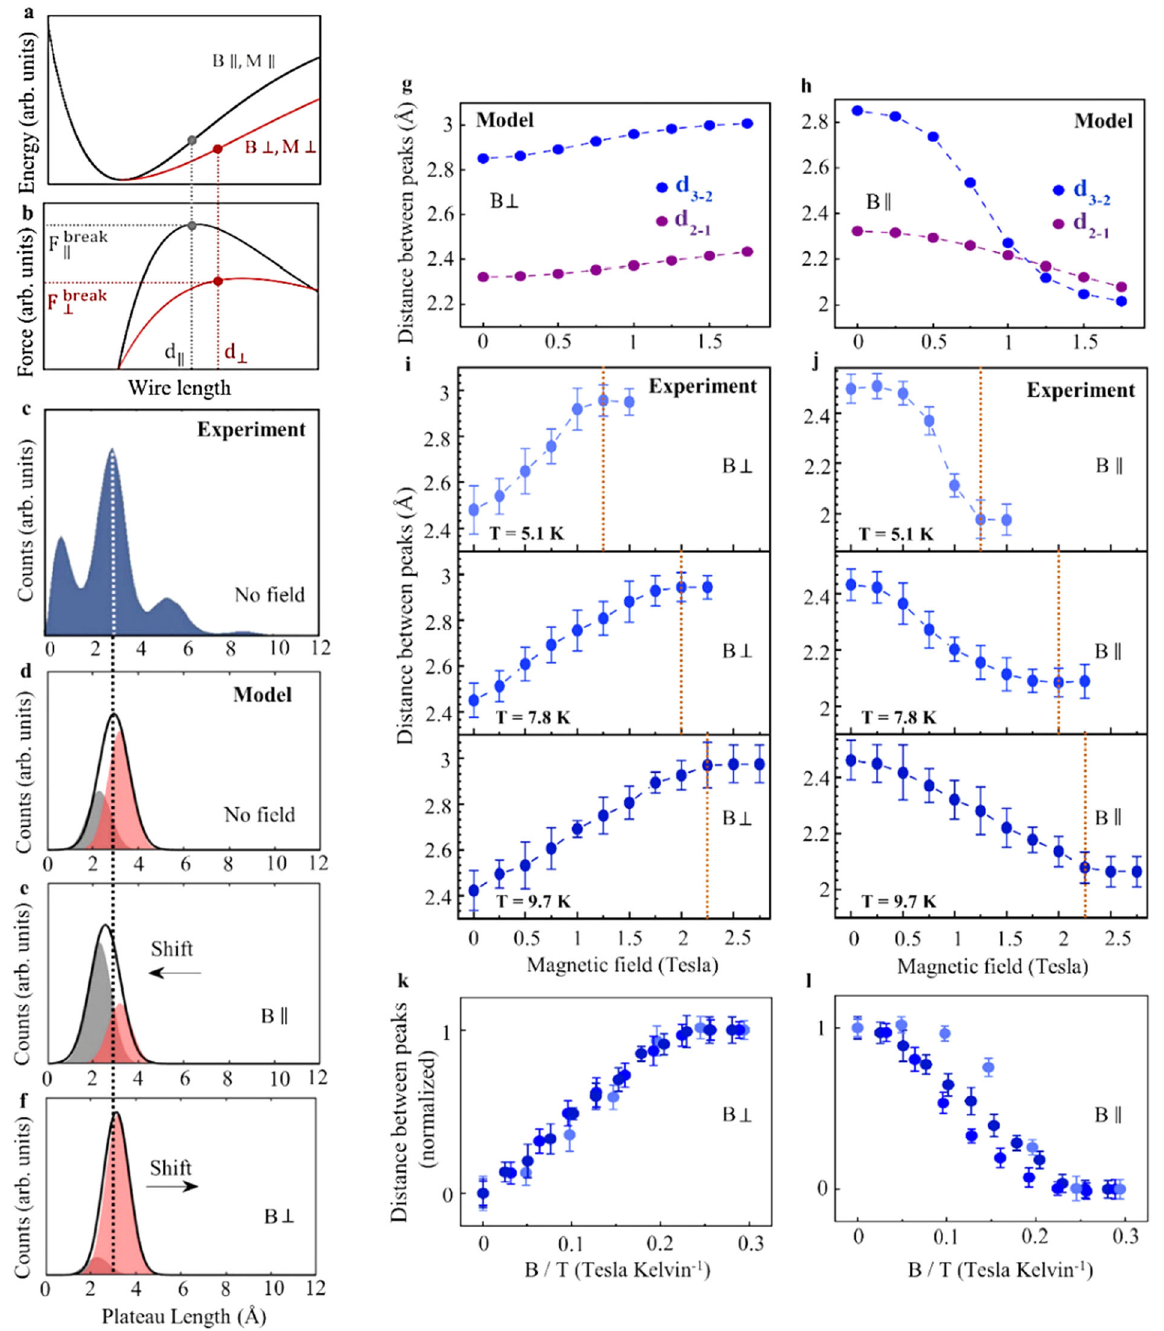
Fig. 4 Minimal model and temperature dependent measurements. a Schematic curve of total energy as a function of wire length for parallel and perpendicular magnetic fi eld and magnetization. b Same as ( a ) for the force. The breaking force (F break k ; ? ) is obtained at different wire length d ||, ⊥ for parallel and perpendicular magnetization and magnetic fi eld orientations. c Experimental length histogram at zero magnetic fi eld (same as Fig. 1c) presented for the sake of comparison to our model. d – f Illustration of the minimal model: ( d ) At zero magnetic fi eld, two peaks represent the distribution of wire lengths with parallel (gray) and perpendicular (pink) magnetizations. In our model, these distributions are given by similar Gaussians multiplied by Zeeman-based Boltzmann weights that depend on the relative orientations and magnitudes of the magnetization and applied magnetic fi eld. The distributions are centered at d n k , d n ? for the n th peak, and their summed contribution (black envelope) is adapted by setting the Gaussian widths to σ = 0.5 Å to fi t the experimental peaks in ( c ). e At a fi nite parallel magnetic fi eld, the two Boltzmann weights are different due to different Zeeman energy for parallel and perpendicular magnetizations. As a result, the heights of the two peaks are different, leading to a down-shift in the position of the maximum of the total distribution (black). f The two distributions at fi nite perpendicular magnetic fi eld. Here, the different Boltzmann weights for parallel and perpendicular magnetizations lead to an up-shift in the position of the maximum of the total distribution (black). g , h Calculated d 2-1 and d 3-2 as a function of perpendicular ( g ) and parallel ( h ) magnetic fi eld. d n k , d n ? are determined by the onset of saturation in Fig. 2c, f. This model captures the opposite shifts in the inter-peak distance for parallel and perpendicular magnetic fi elds for both magnetization directions. i , j Inter-peak distance as a function of perpendicular ( i ) and parallel ( j ) magnetic fi eld for different temperatures. k , l Same as in ( i ), ( j ), with magnetic fi eld divided by the